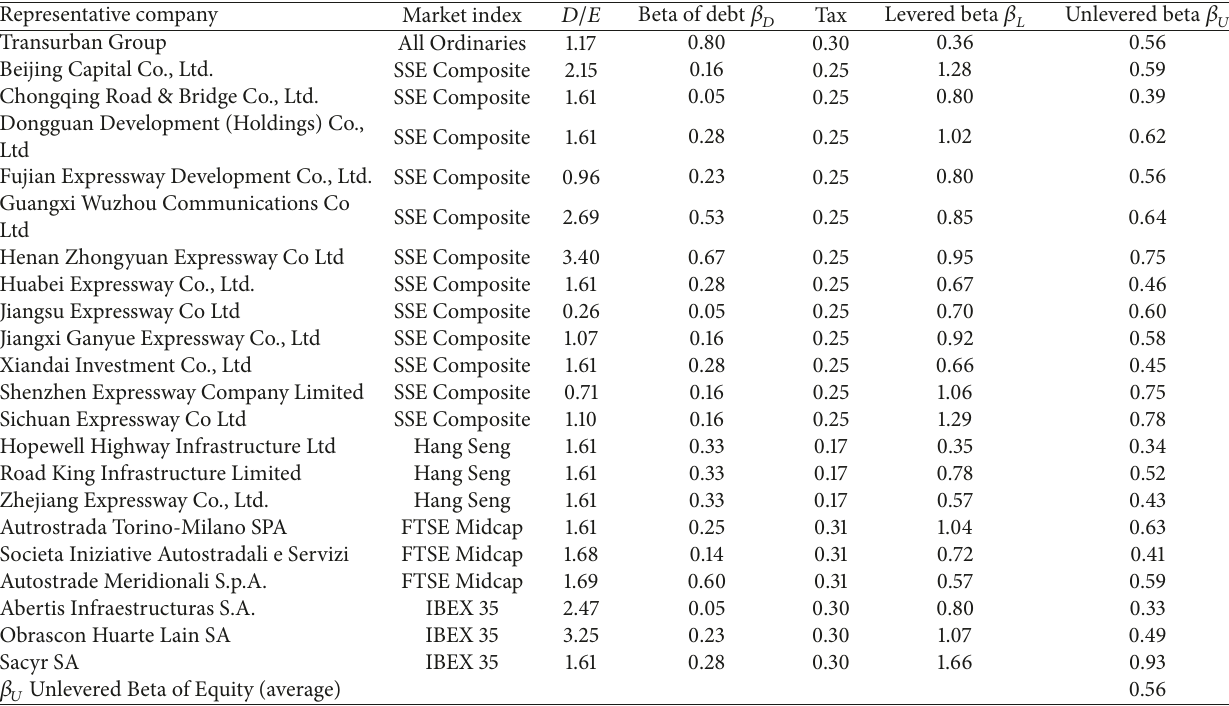
Table 4: Unlevered Betas of equity for representative companies ( 𝛽 𝑈 ).